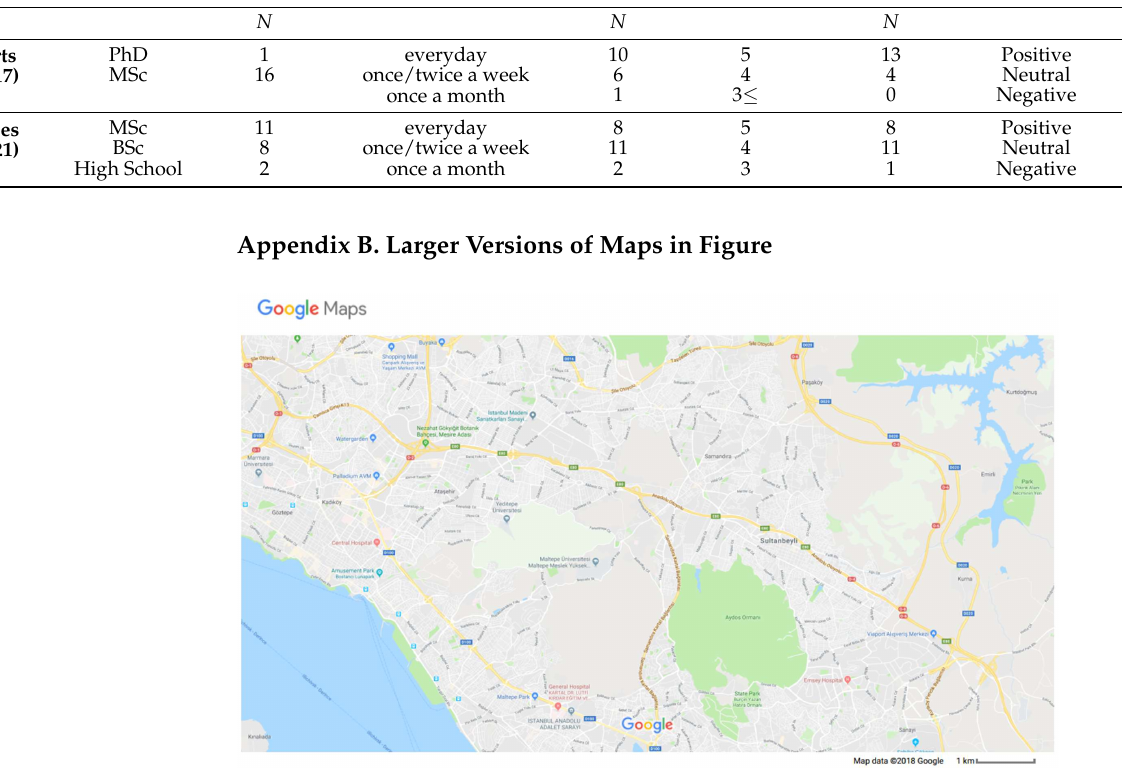
Table A1. User characteristics of the recruited participants [48].